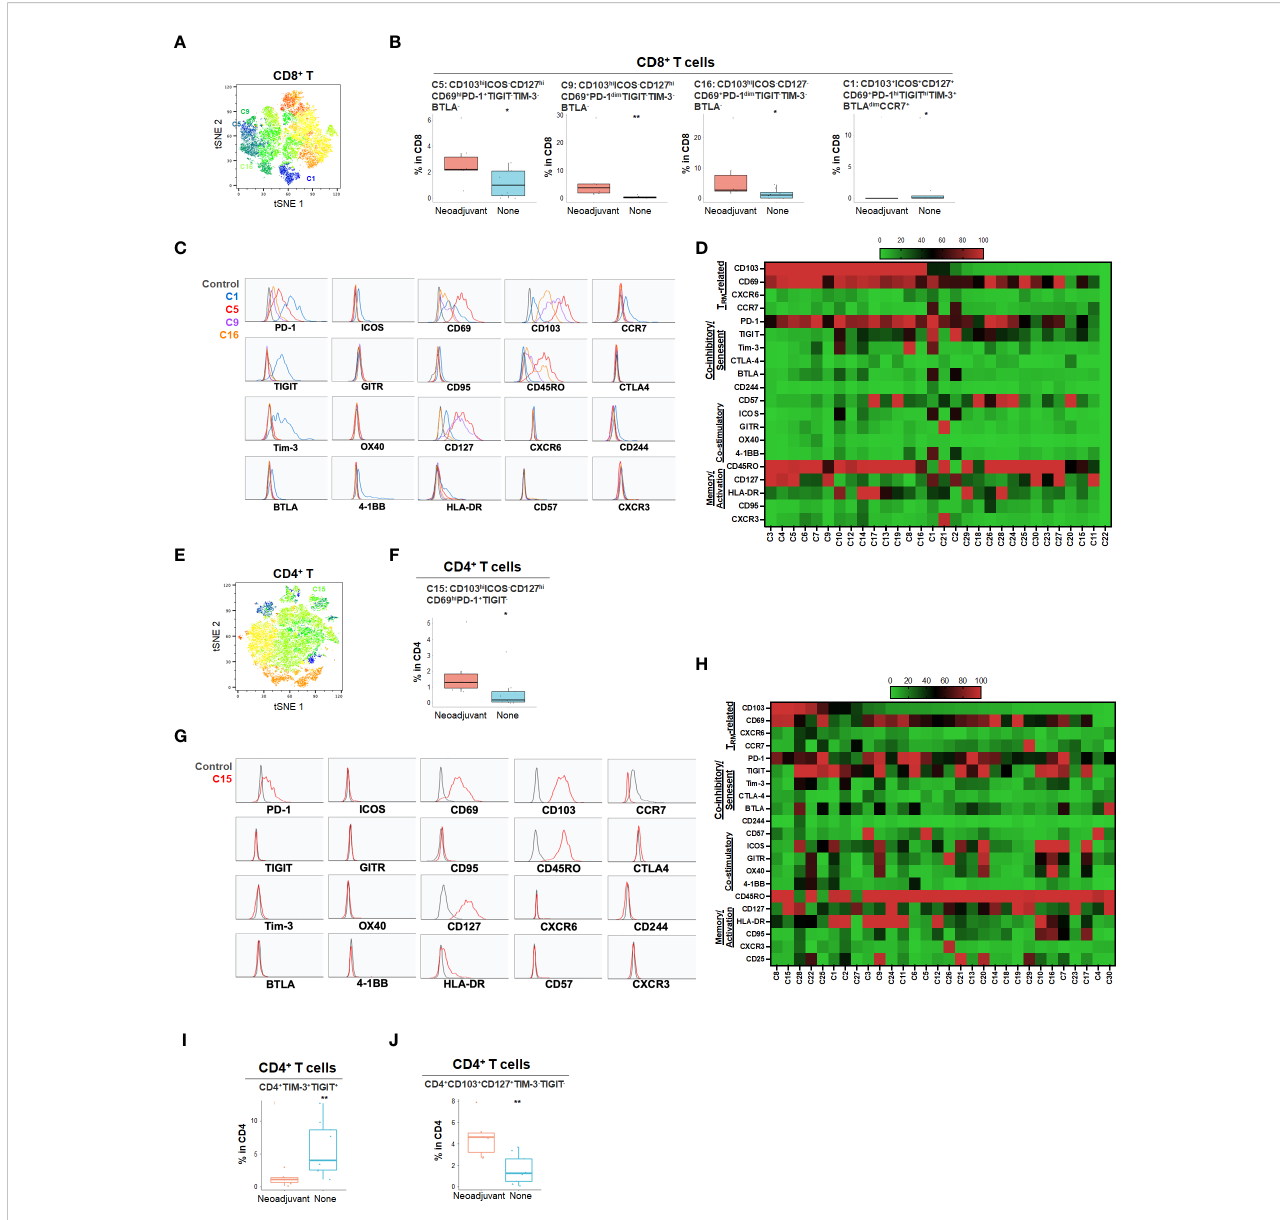
FIGURE 6 Effect of neoadjuvant chemotherapy on T cell phenotypes in PDA patients (A) tSNE projection of CD8+ T cells showing 30 FlowSOM clusters identi fi ed from PDA patients treated with (n=6) or without (n=8) neoadjuvant chemotherapy. Signi fi cantly enriched clusters in neoadjuvant treatment group (C5, C9, C16) and no treatment group (C1) are labeled. (B) Boxplots showing phenotypes of CD8+ T cell clusters enriched following neoadjuvant chemotherapy. Box middle lines, median; box limits upper and lower quartiles; box whiskers, 1.5x the interquartile range. *p<0.05, **p < 0.01, Kruskal- Wallis test. (C) Histograms show the single marker phenotypes of CD8+ T cell clusters C5 (red), C9 (purple) and C16 (orange) enriched in PDA patients treated with neoadjuvant chemotherapy and cluster C1 (blue) enriched in PDA patients without neoadjuvant treatment. (D) Expression of TRM-related markers, co-inhibitory/senescent markers, co-stimulatory markers and memory/activation markers in 30 clusters of CD8+ T cells is shown in heatmap which is arranged based on the expression level of CD103. (E) tSNE projection of CD4+ T cells showing 30 FlowSOM clusters identi fi ed from PDA patients treated with (n=7) or without (n=9) neoadjuvant chemotherapy. Signi fi cantly enriched cluster C15 in neoajuvant treatment group is labeled. (F) Boxplot shows cluster C15 (p<0.05) increased in CD4+ T cells from PDA patients treated with neoadjuvant. (G) Histograms show the phenotype of C15 (red) in CD4+ T cells from PDA patients treated with neoadjuvant chemotherapy. (H) Expression of TRM-related markers, co-inhibitory/senescent markers, co-stimulatory markers and memory/activation markers in 30 clusters of CD4+ T cells is shown in heatmap which is arranged based on the expression level of CD103. (I, J) . Combinatoric frequency analysis of CD4+ marker combinations in response to neoadjuvant chemotherapy (TerraFlow- Methods). Boxplots showing representative phenotypes of CD4+ T cells that are signi fi cantly higher in treatment-naïve PDA patients (I) or patients receiving neoadjuvant chemotherapy (J)